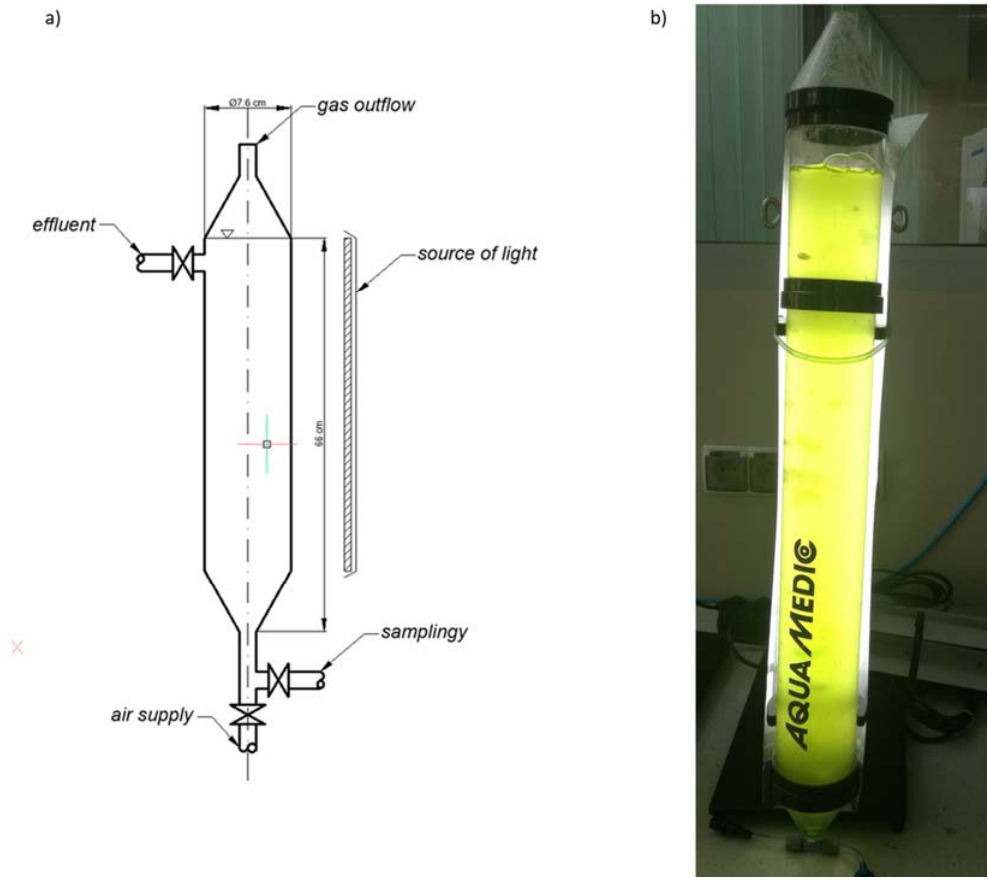
Figure 6. Scheme of photobioreactor used for breeding the algae ( a ). Photo of the photoreactor used in the research ( b ).